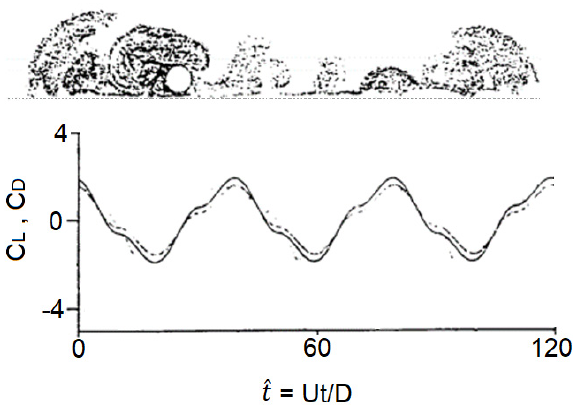
Figure 19. The flow pattern at t = 120, and the force coefficients for G/D = 0.2, Kc = 40 and Re = 25,000.